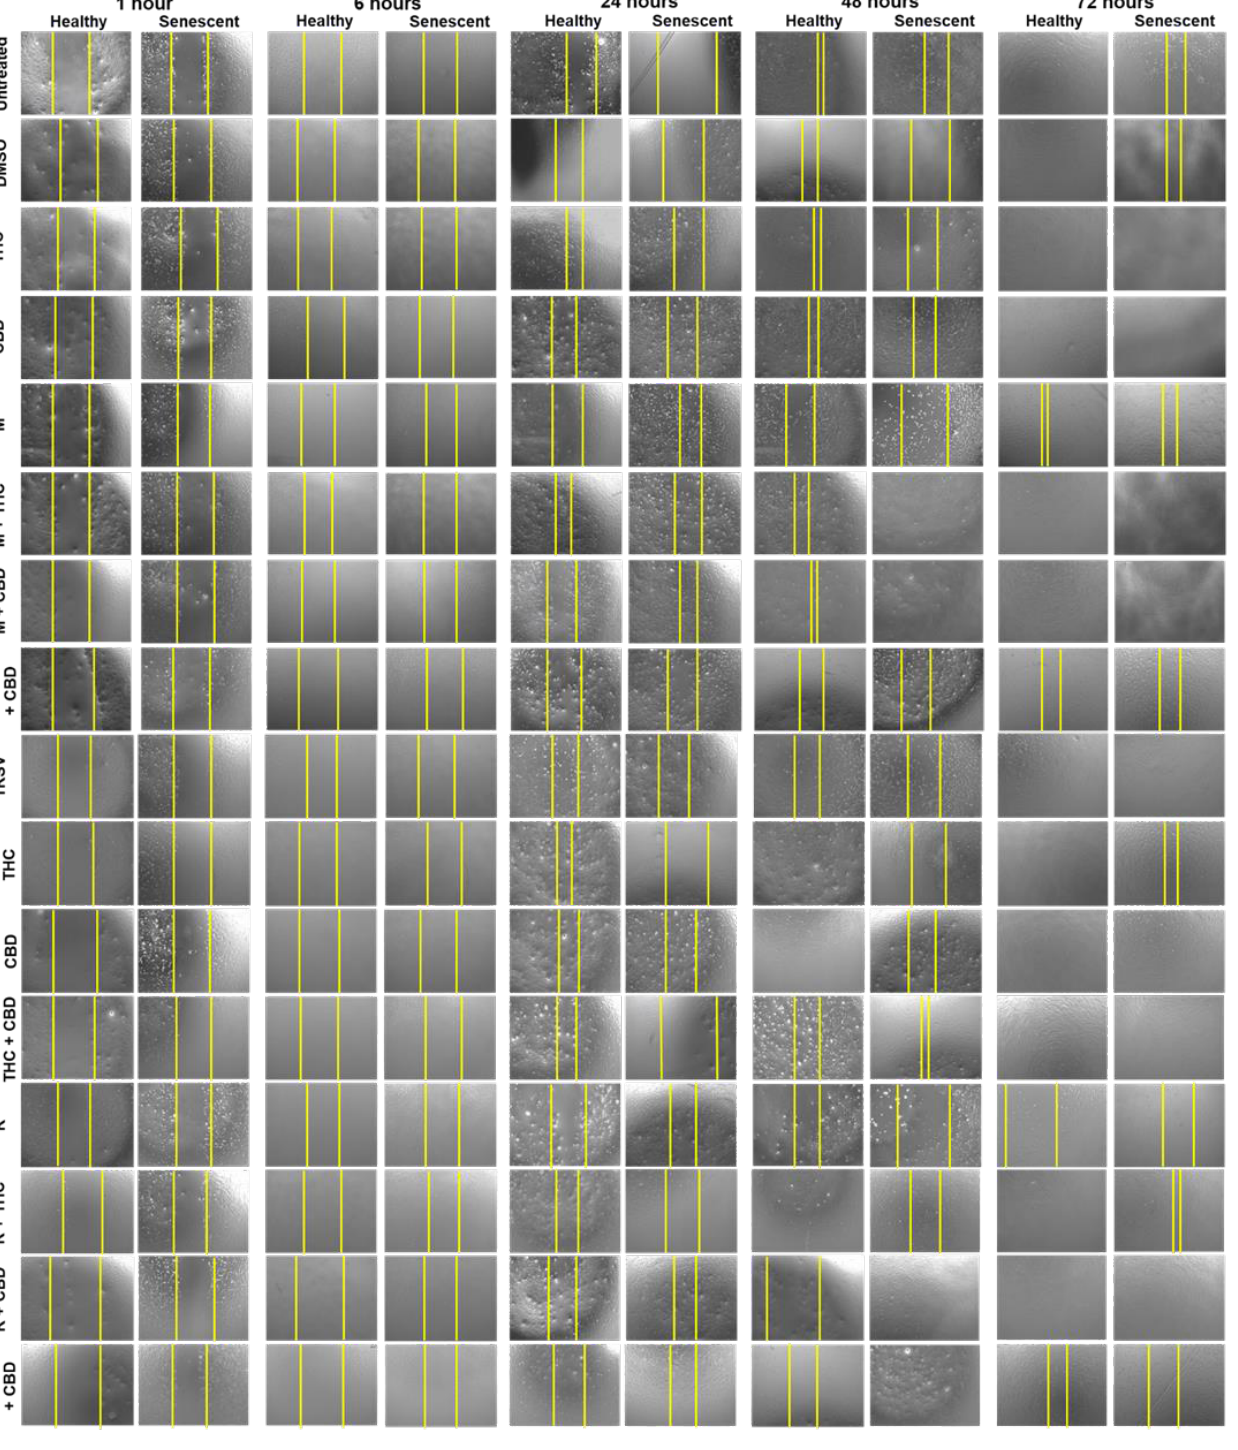
Figure 4. The effect of nutrient signaling regulators combined with phytocannabinoids on human skin fibroblasts CCD-1064Sk (p.11) in the wound-healing assay. Images show size of wounds after exposure to NSRs and/or pCBs for 1, 6, 24, 48, and 72 h in healthy and SIPS fibroblasts. Yellow lines delineate the edge of the wound. CBD, cannabidiol; DMSO, dimethyl sulfoxide (vehicle), M, metformin; R, rapamycin; THC, ∆ -9-tetrahydrocannabinol; TRSV, triacetylresveratrol. Images were captured at 80X magnification using a light microscope.